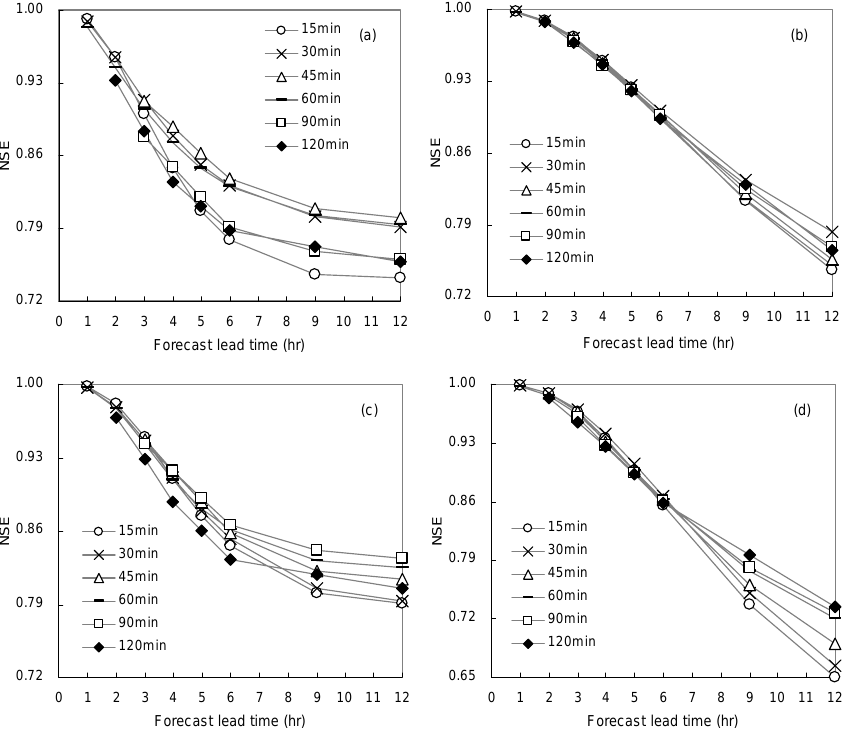
Figure 6 Decreasing performance of the forecasting system constructed using data with different time intervals as the increase of the forecast lead time, for the catchments of Bellever, Halsewater, Brue and Bishop_Hull, respectively in (a), (b), (c) and (d). simply building the model using data as they are originally